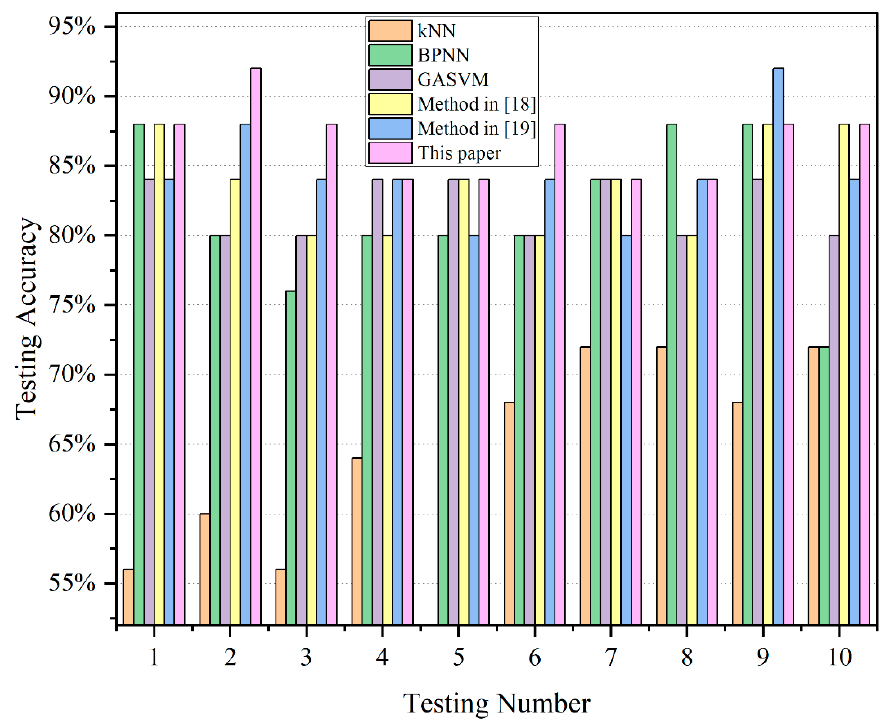
Figure 6. Testing accuracy of different methods.